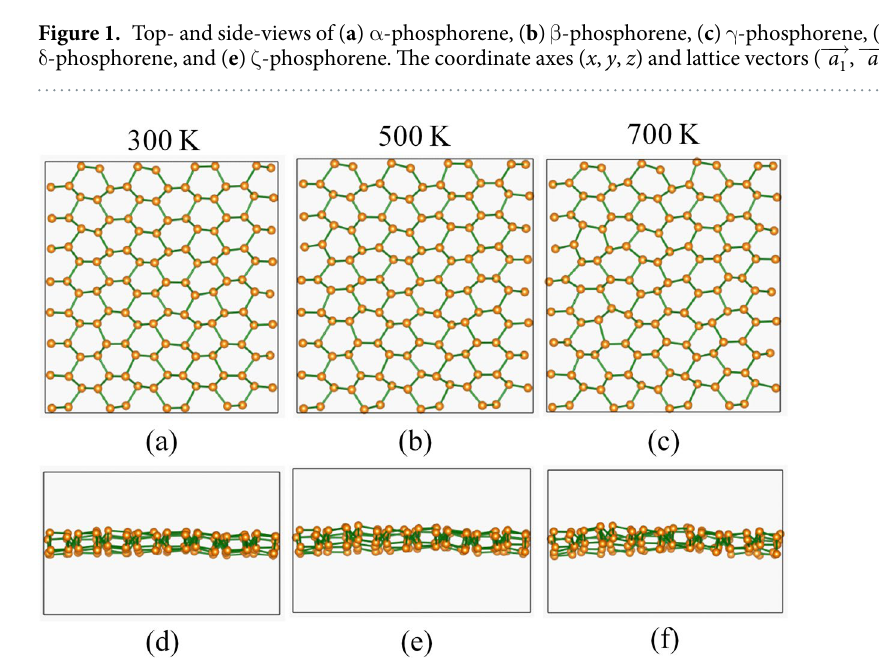
→ , a 2 ) are indicated. 1